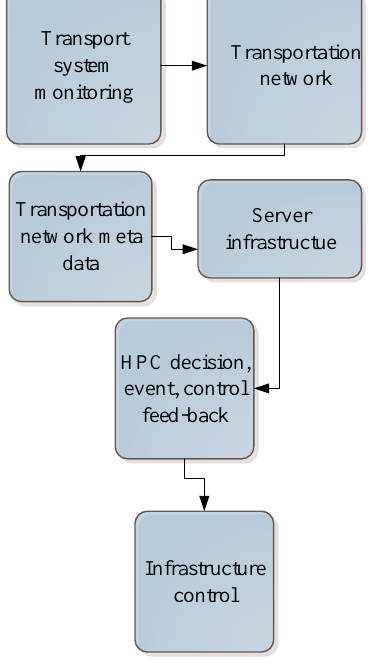
Fig. 2. City surveillance system with monitoring center.